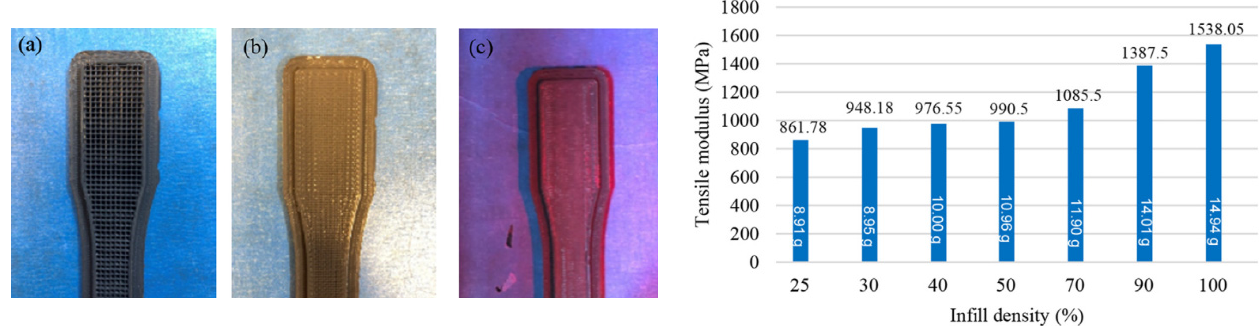
Figure 17. FDM printed specimens with different infill densities: ( a ) 25% ( b ) 50%, ( c ) 100%; the relationship between the tensile modulus and the infill density for pure PLA [125].